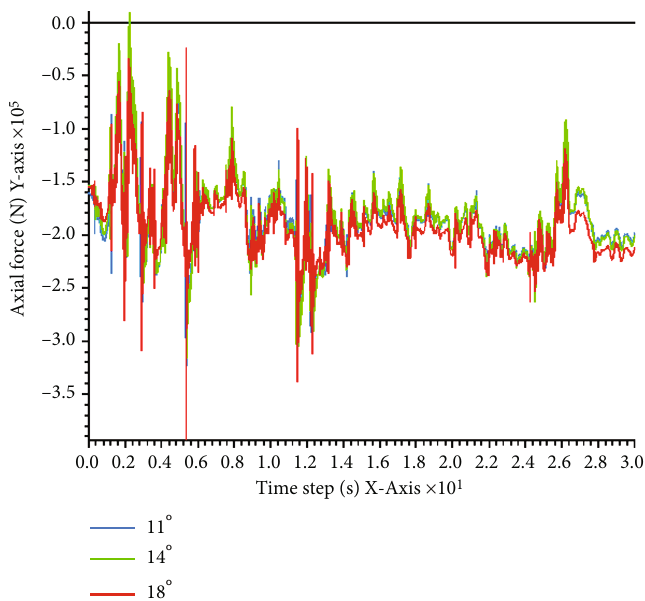
Figure 18: Distribution of dynamic earth pressure at W3 under di ff erent anchor